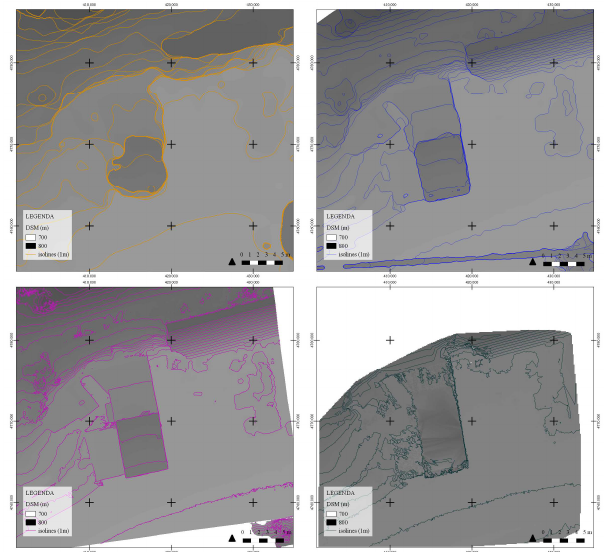
Figure 13. DSM comparison. Top: eBee DSM (left); DJI DSM (right). Down: fusion model DSM (left); ZEB1 DSM (right).